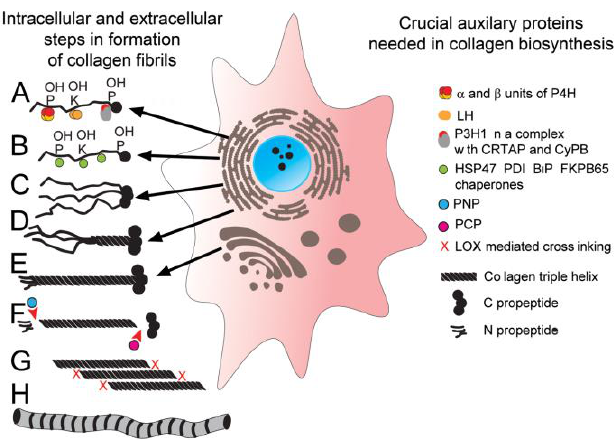
Figure 1. A schematic of intracellular and extracellular molecules and processes that control the formation of collagen fibrils. ( A ) Biosynthesis and post-translational modifications of individual procollagen α-chains; during this process, selected proline and lysine residues are hydroxylated. ( B ) The interaction of procollagen chains with protein chaperones that control the folding of triple helices. ( C , D ) The selection of procollagen chains and nucleation of triple helices. ( E ) Translocation and secretion of procollagen molecules into the extracellular space. ( F ) Cleavage of the N propeptide by PNP and C propeptides by PCP. ( G , H ) Assembly of collagen molecules into fibrils and formation of covalent cross-links (X). Symbols: P; proline residues, K; lysine residues, P4H; prolyl 4-hydroxylase, LH; lysyl hydroxylase, P3H1; prolyl 3-hydroxylase, CRTAP; cartilage-associated protein, CyB; cyclophilin B, HSP47; heat shock protein 47, PDI; disulfide isomerase, FKPB65; immunophilin, PNP; procollagen N proteinase, PCP; procollagen C